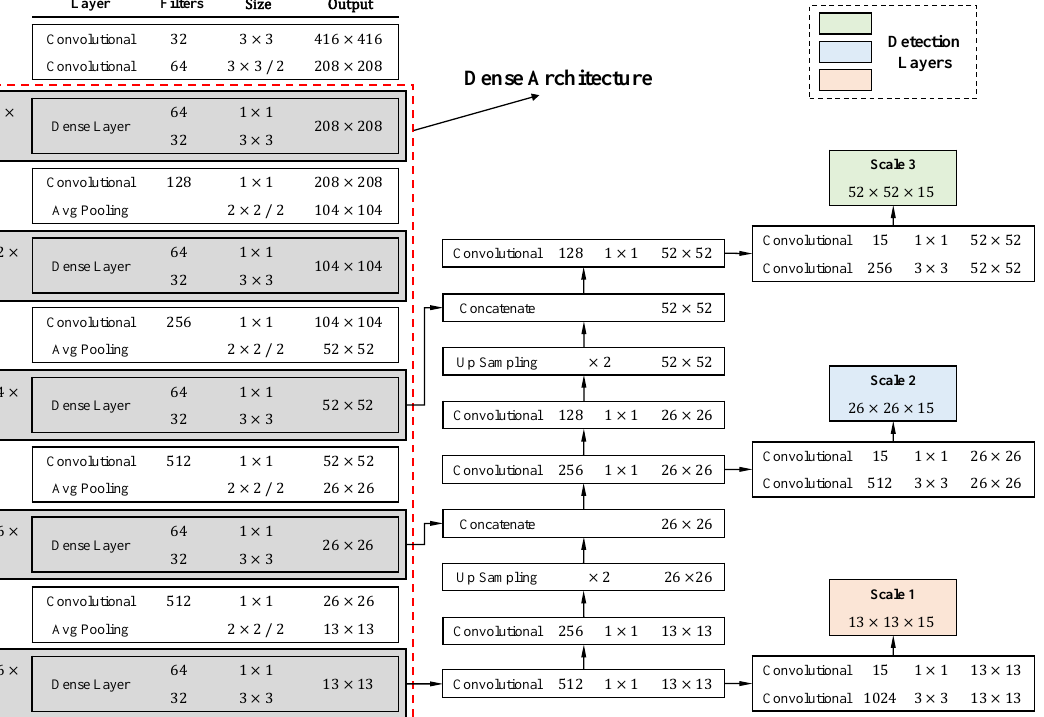
Figure 7. Dense architecture of the proposed